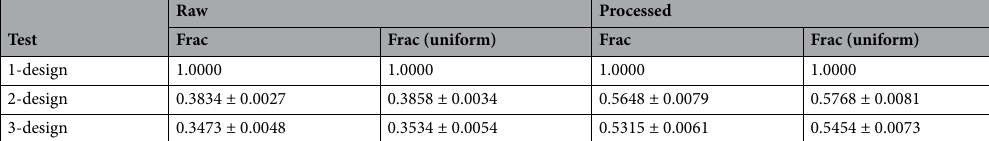
Table 4. Fraction of states for which the ensemble of unitaries generated using the ibmq_toronto quantum processor passed the different tests. ‘Raw’ shows the fractions without quantum readout error mitigation. ‘Processed’ shows the fractions with quantum readout error mitigation. The column with ‘uniform’ shows the fractions obtained when replacing the experimentally determined relative frequencies with uniform